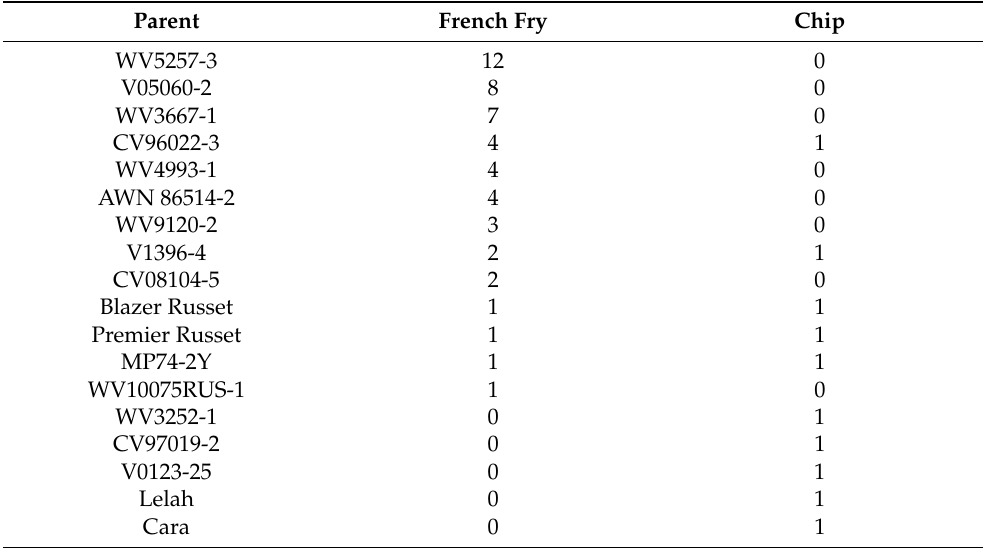
Table 3. Frequency of progeny with higher proportion of Excellent and Acceptable shaped tubers compared to the highest performing check variety (French fry: Blazer Russet; Chip: AAC Hamer). Parent French Fry